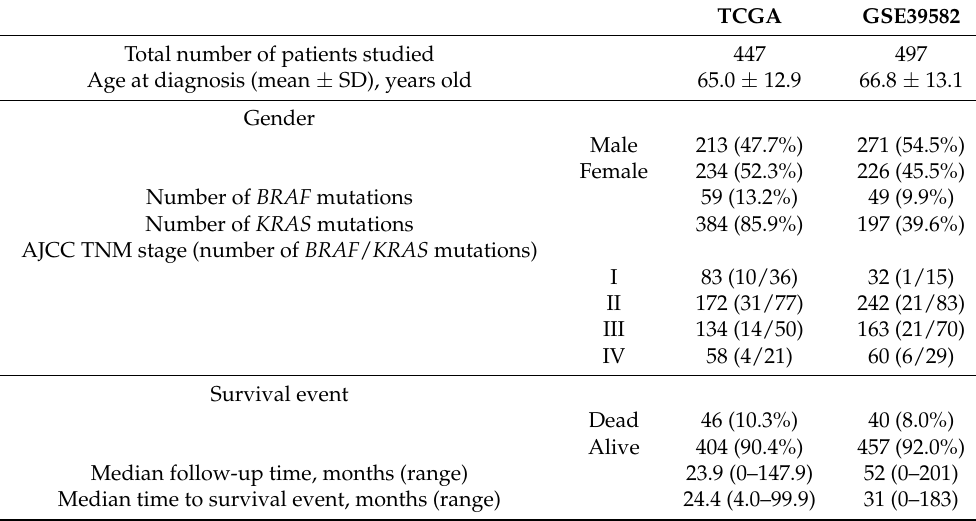
Table 1. Baseline characteristics of